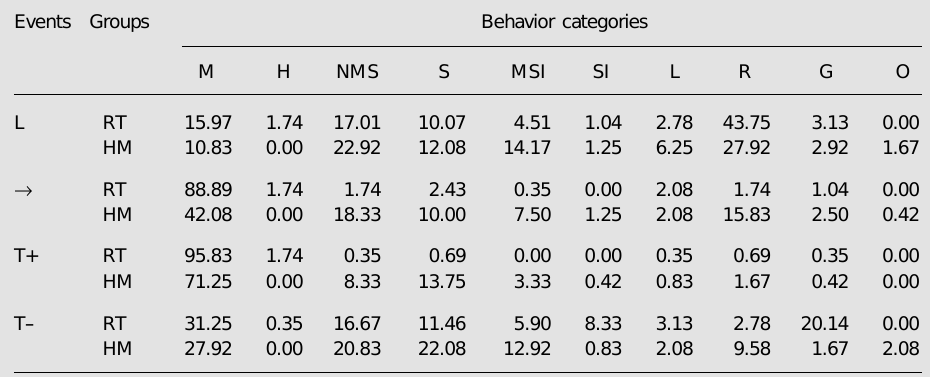
Table 1. Behavioral categories of Wistar rats (RT group) and hamsters (HM group) during periods of serial fi compound trials [feature (L); empty interval ( ); target followed by reinforcement (T+)], and during tone-alone trials (T-), in the last 8